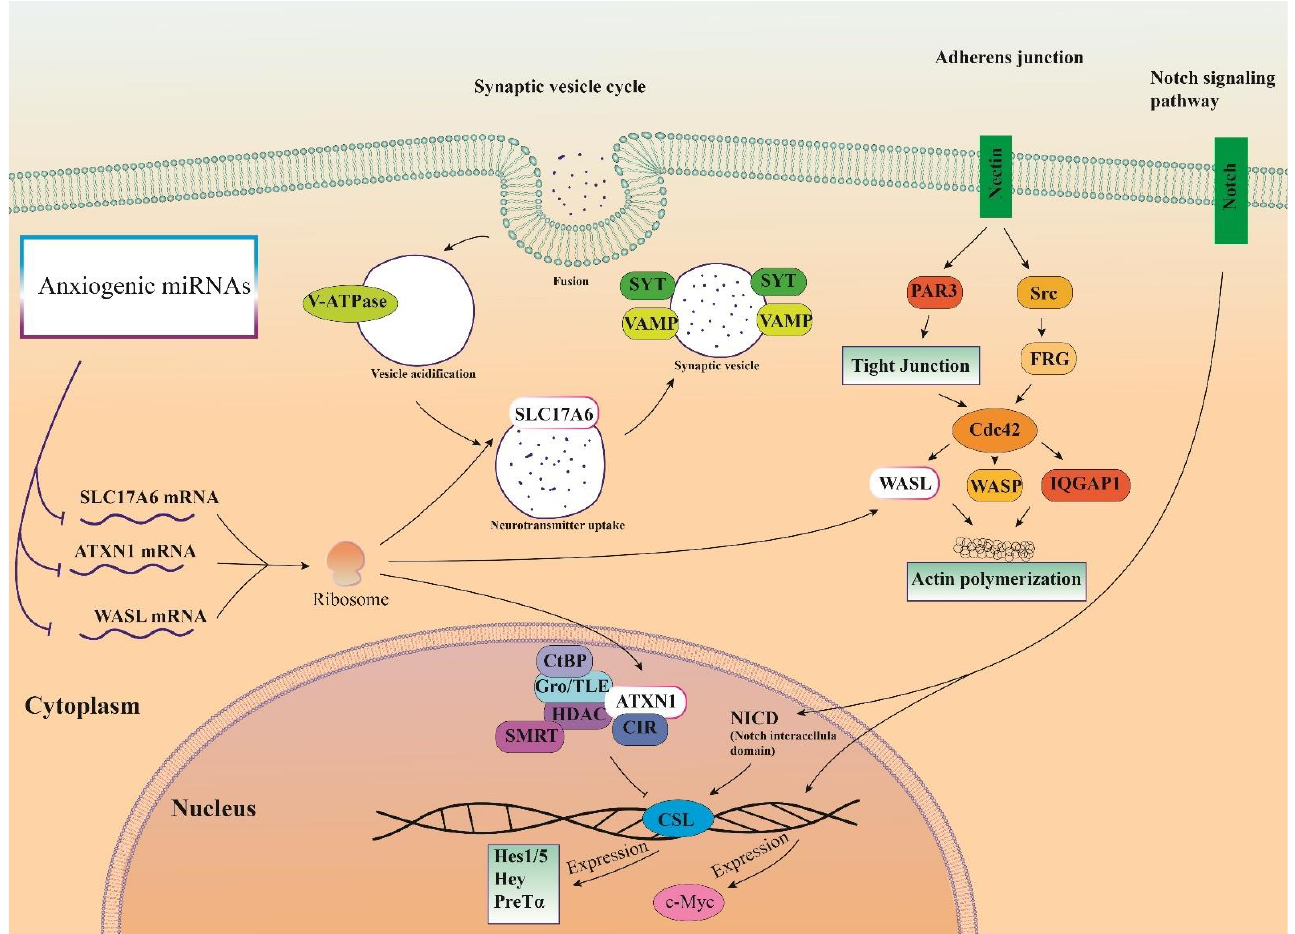
Figure 4. Illustration of the signaling pathways of highlighted anxiogenic miRNAs (miR-19b, miR-92a, and 218). Genes were targeted by highlighted anxiogenic miRNAs participating in Notch signaling, adherence junction, and synaptic vesicle cycle signaling pathways.